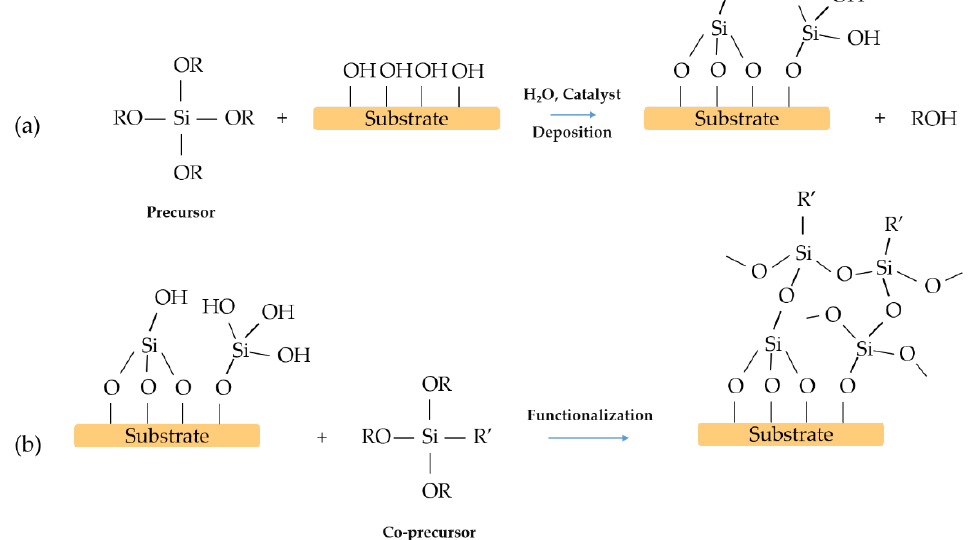
Figure 10. Example scheme of a two-step process: ( a ) deposition of the film, ( b ) functionalisation of the film. the